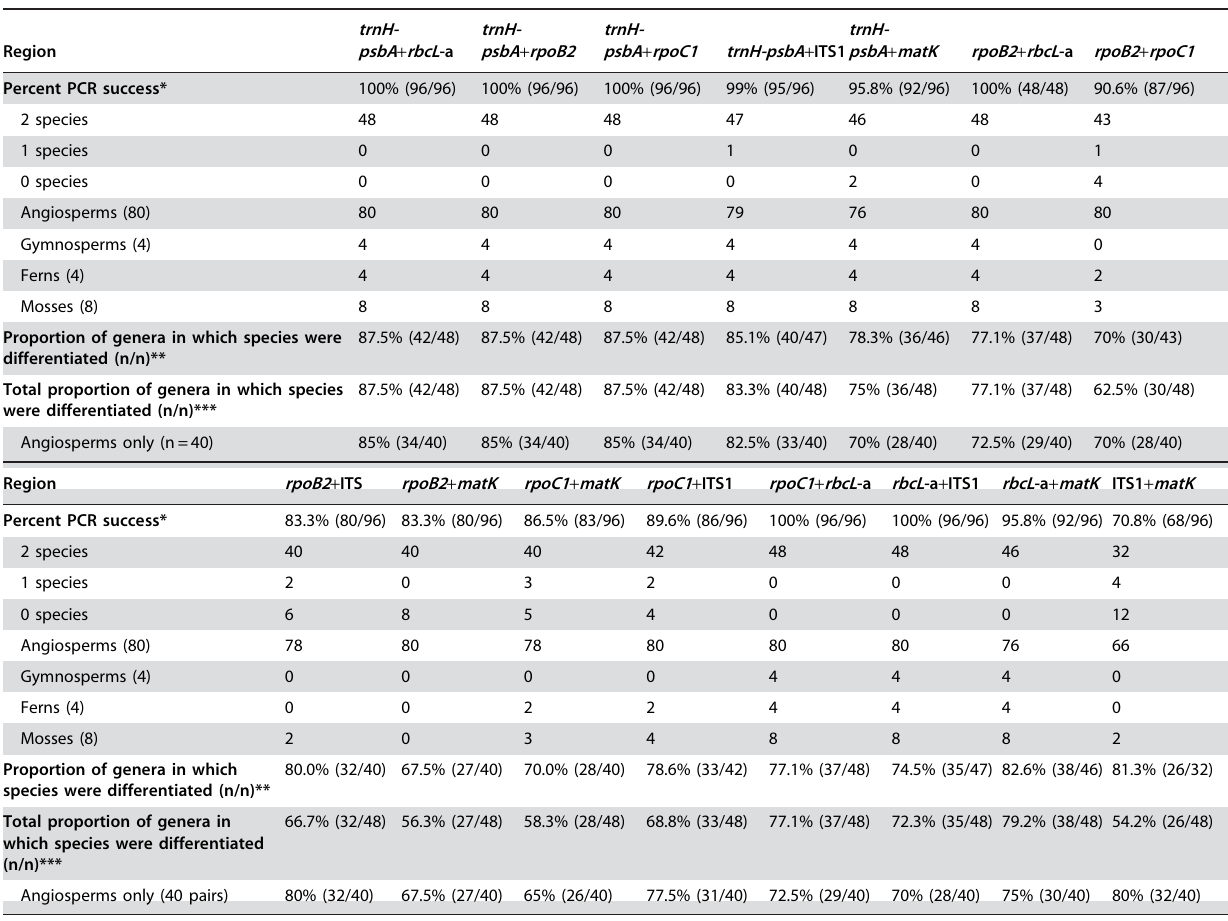
Table 4. Comparisons of results for pairs of two loci for trnH-psbA , rpoB , rpoC , rbcL -a, matK , and ITS tested in all combinations